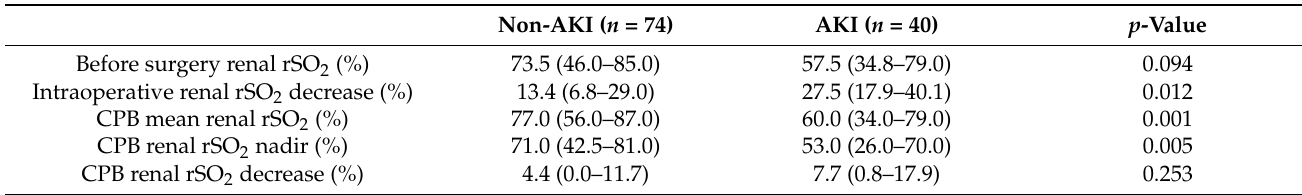
Table 7. Cumulative saturation of CPB Renal rSO 2 score